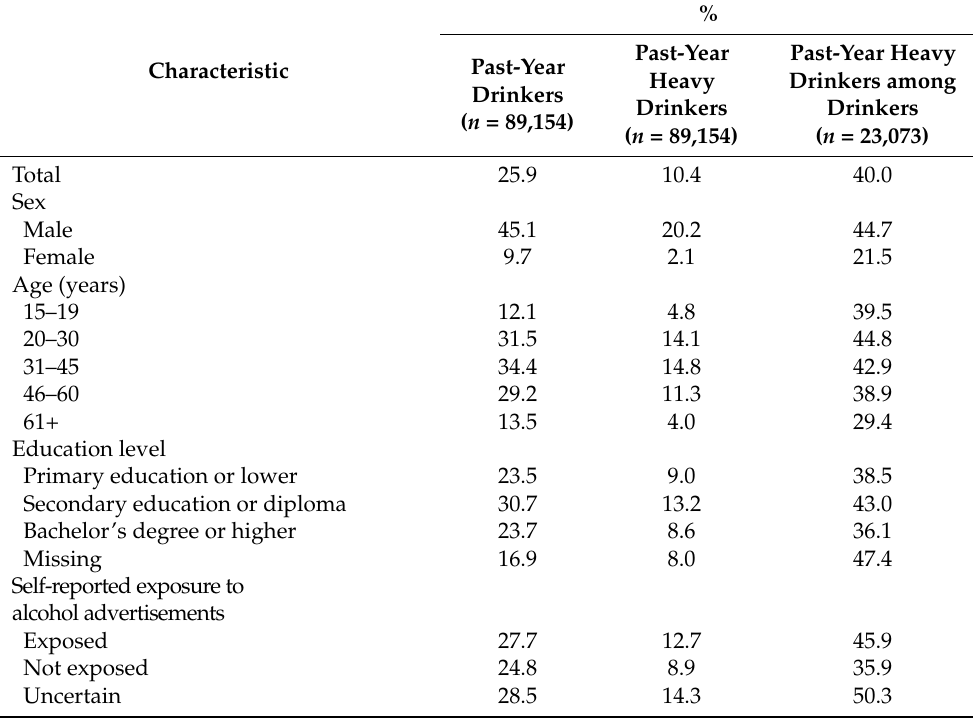
Table 2. Proportions of past-year drinkers, past-year heavy drinkers, and past-year heavy drinkers among drinkers by